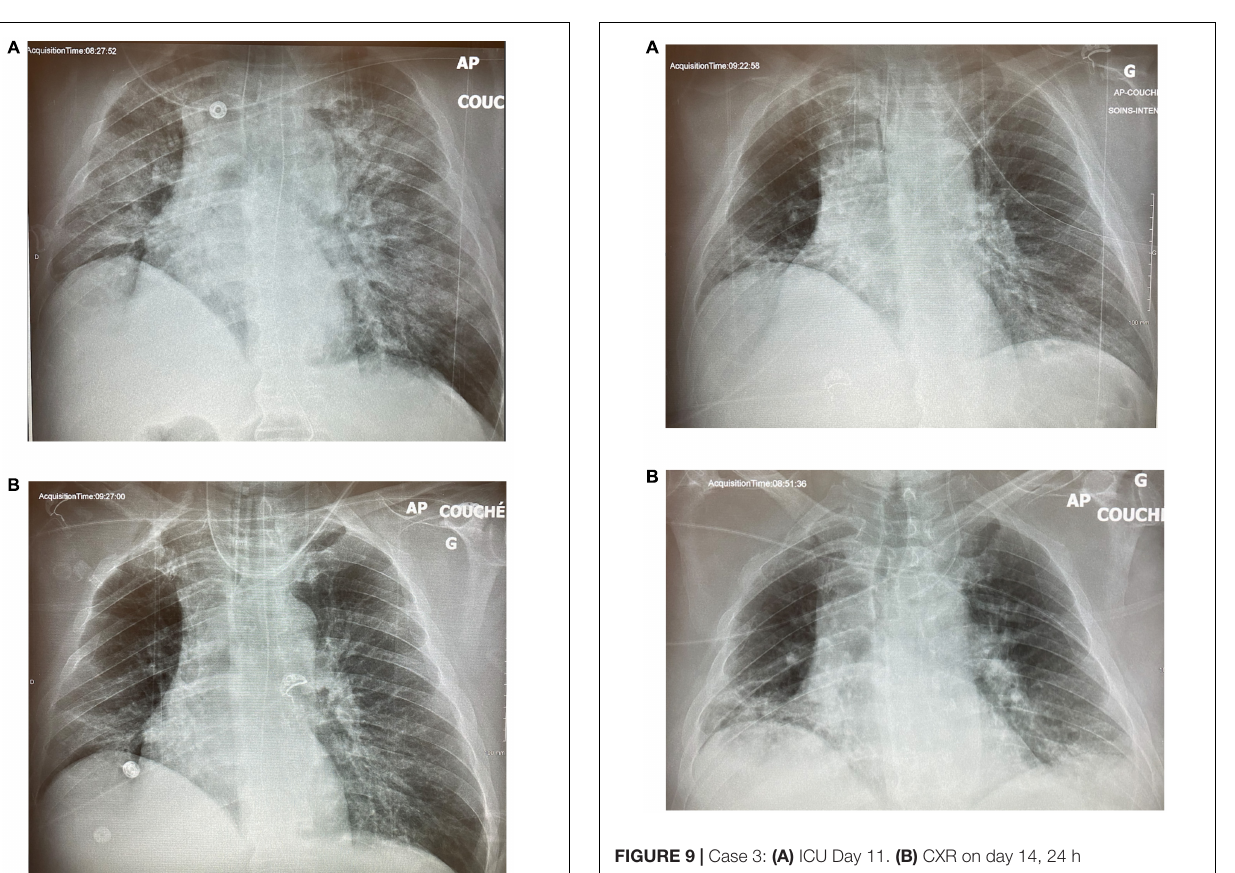
FIGURE 9 | Case 3: (A) ICU Day 11. (B) CXR on day 14, 24 h